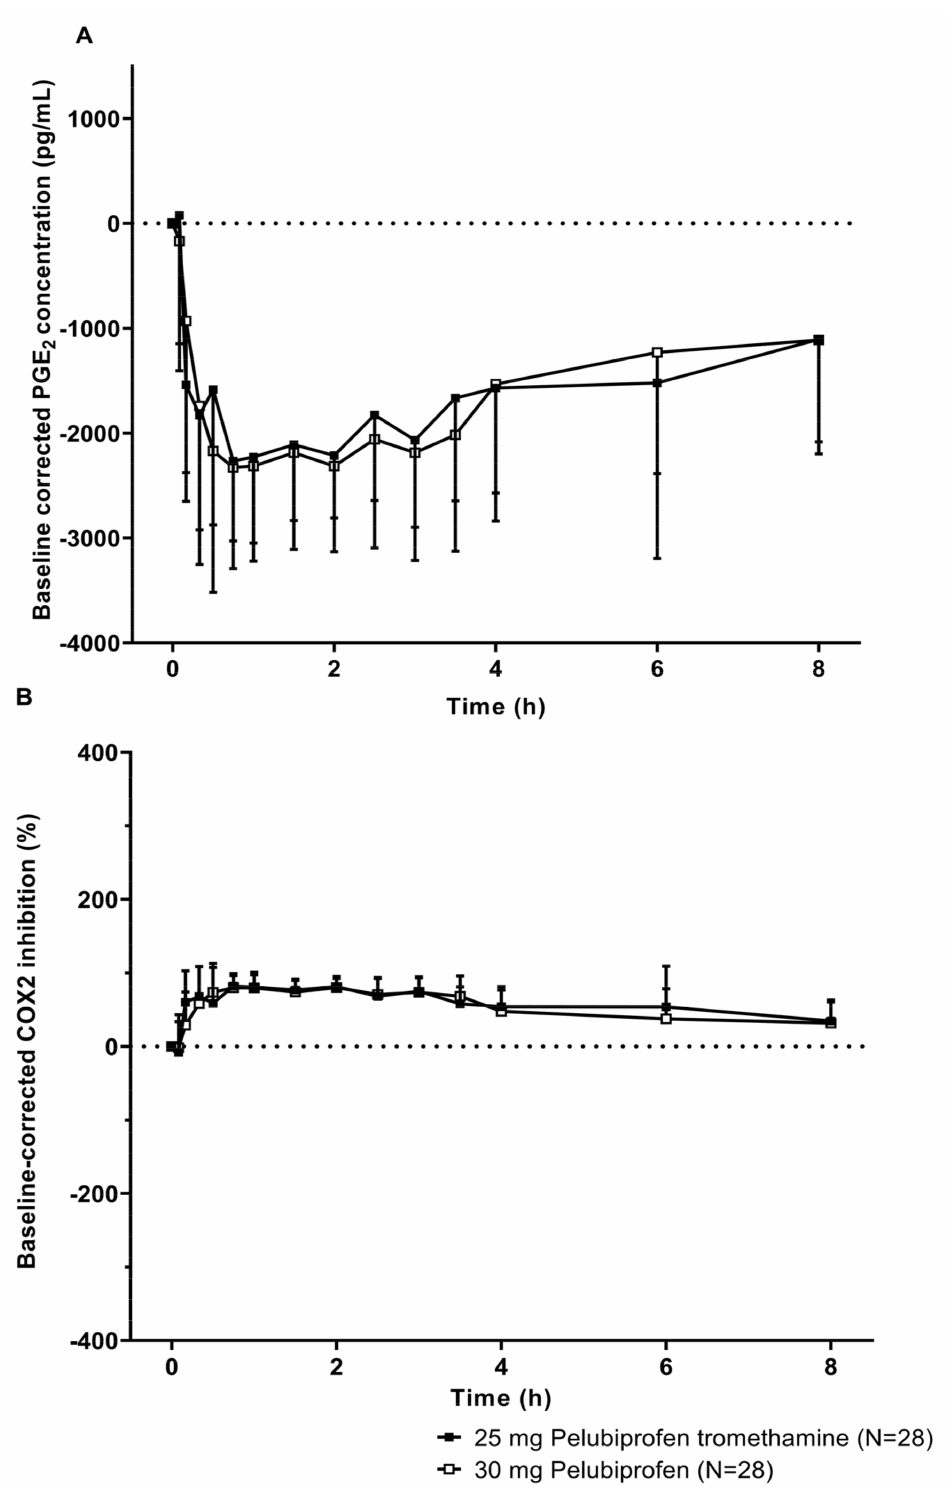
Figure 4. The extent of COX-2 inhibition determined from PGE 2 concentration from baseline levels after a single oral administration of 25 mg of pelubiprofen tromethamine or 30 mg of pelubiprofen in periods 1 and 2 of Study I are shown as the baseline-corrected PGE 2 concentration over time ( A ) and percent change from baseline COX-2 inhibition over time ( B ). The upper ( A ) and lower ( B ) panels are shown in linear scale as (mean − standard deviation) and (mean + standard deviation), respectively. Data include all subjects in period 1 and 2 without the potential outliers (A03 and